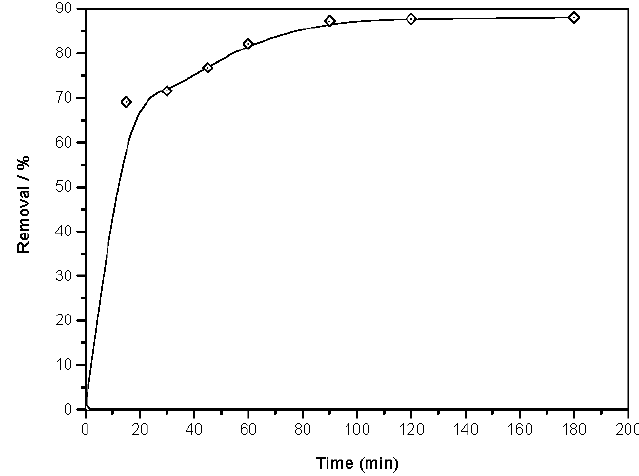
Figure 5. Influence of contact time on phenol sorption process on to magnetic ZnO nanotubes (pH = 5, initial phenol concentration = 10 ppm, agitation speed = 440 rpm, material dosage = 2 g/L and temperature = 25 °C).